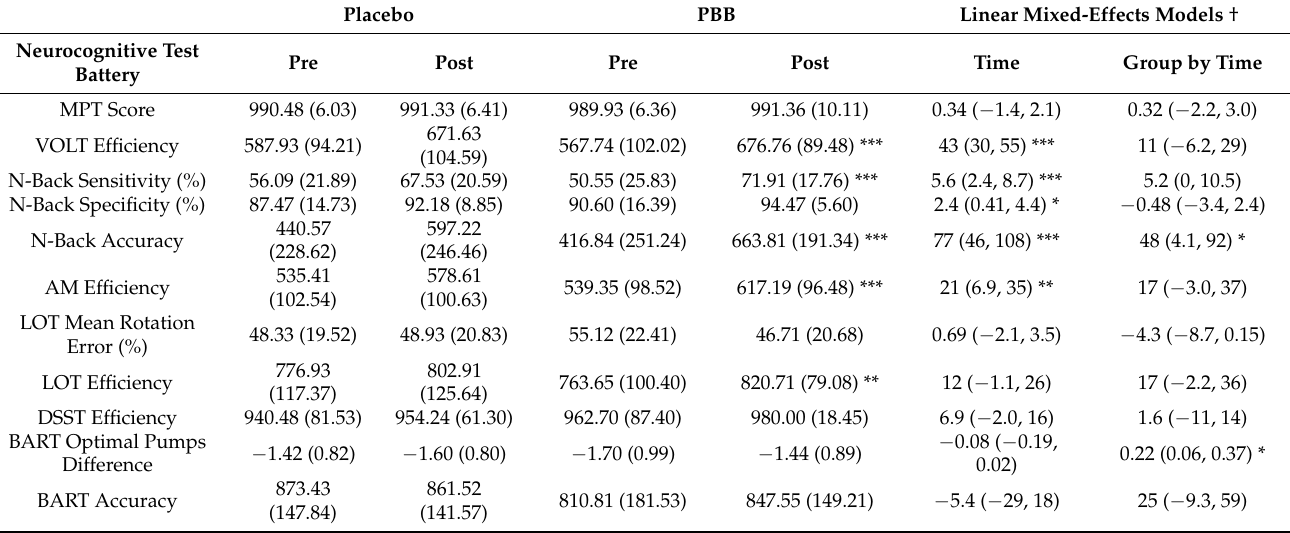
Table 4. Pre–post comparisons within and between groups on neurocognitive